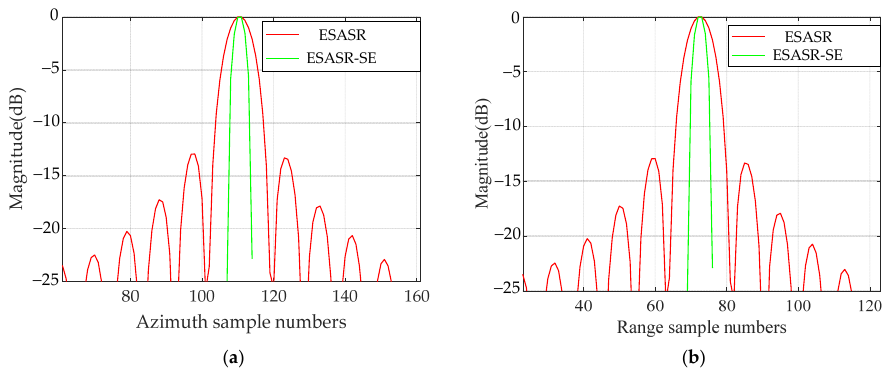
Figure 11. Point target response in azimuth and range profile of ESASR, ESASR-SE: ( a ) Point target response in azimuth profile; ( b ) Point target response in range profile.